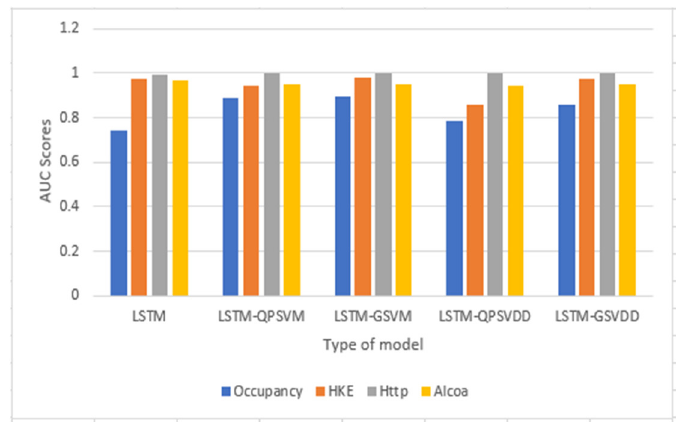
Figure 9. Area under Curve for multiple LSTM based models.